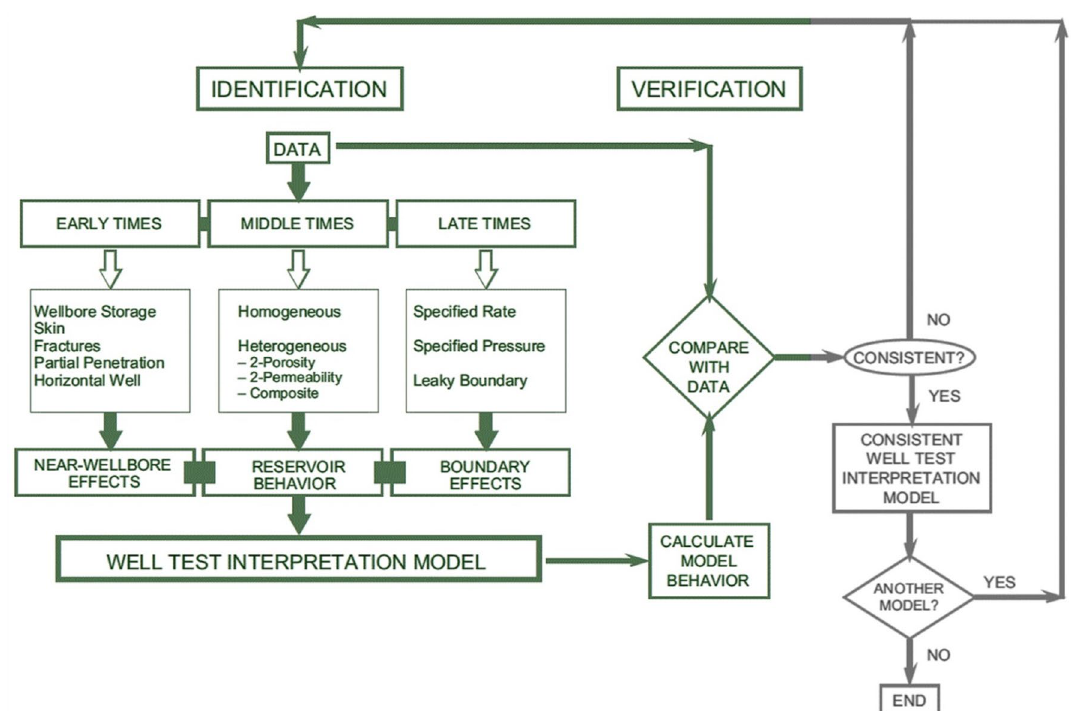
Fig. 2 Schematic of the complete interpretation process of well testing (Bodin and Lopes